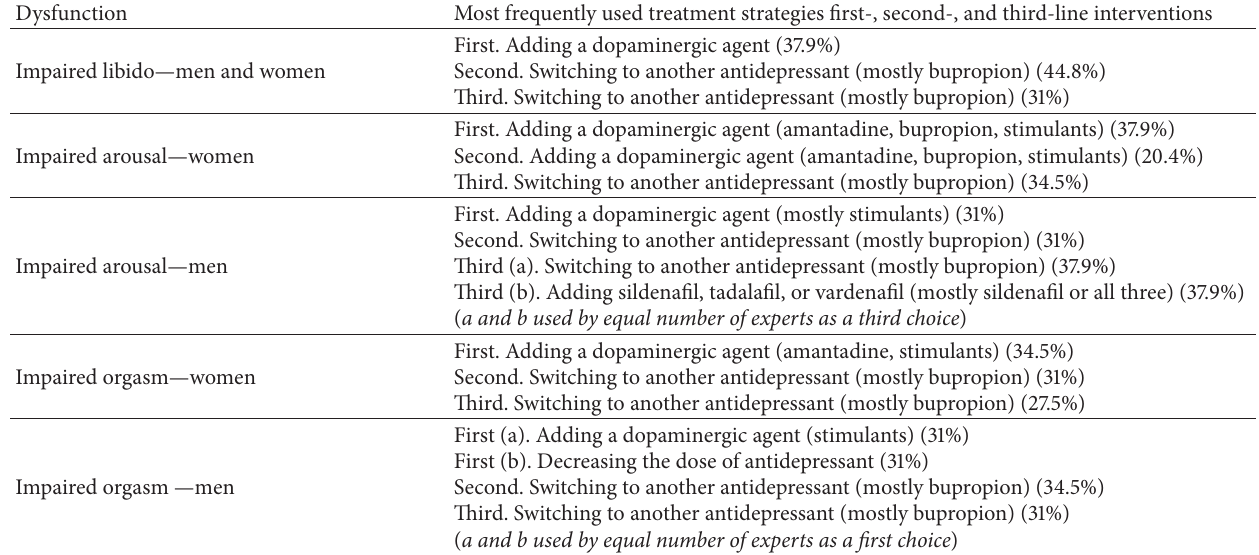
Table 2: Commonly adopted strategies for managing sexual dysfunction associated with antidepressant drugs. Questionnaire survey, US psychiatrists, expertise in managing sexual dysfunction [41]. Percentages indicate the proportion of physicians using that strategy as their preferred